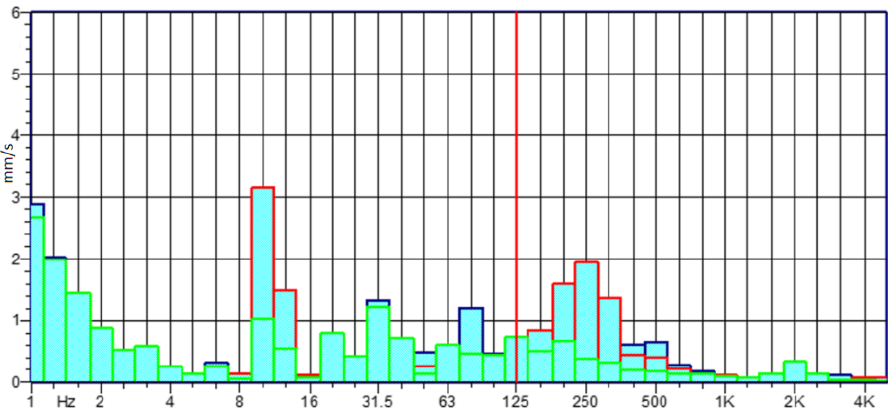
Figure 7. Frequency spectrum for bearing nr. 7 at 2000 rpm — Lamborghini 135.